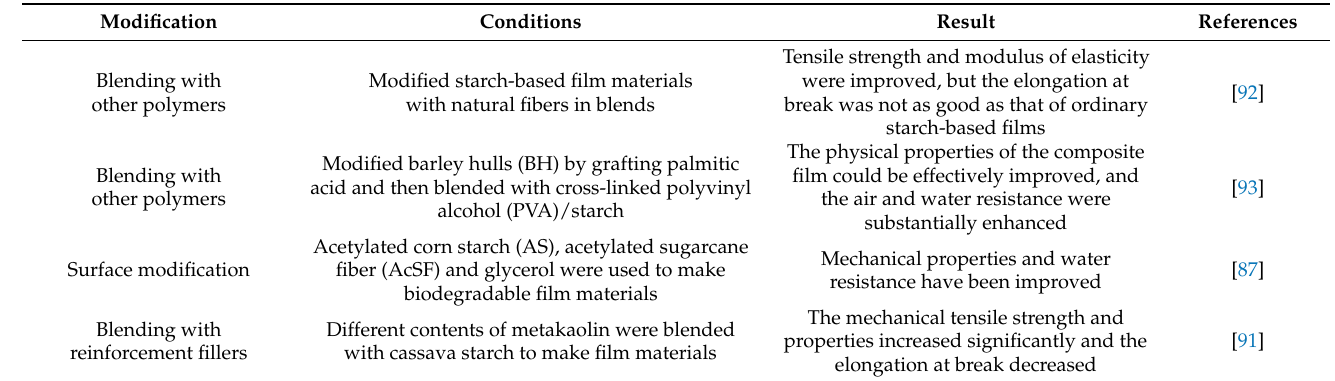
Table 4. The different modifications of starch-based film